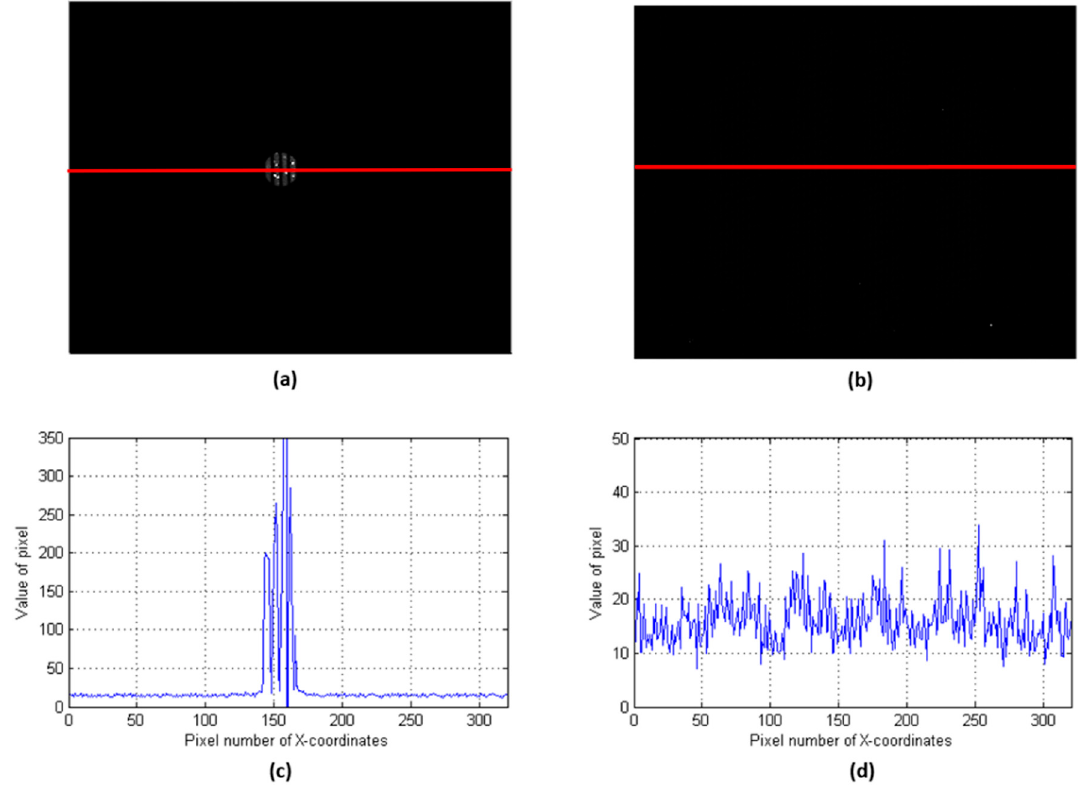
Figure 10. Images of weak light conditions. ( a ) Image acquired by an 8-mm lens, ( b ) image acquired by a 73 mm lens, ( c ) the row of data from the red line shown in ( a ), ( d ) the row of data from the red line shown in ( b ). In weak light conditions, the traditional system was no longer able to obtain a signal.